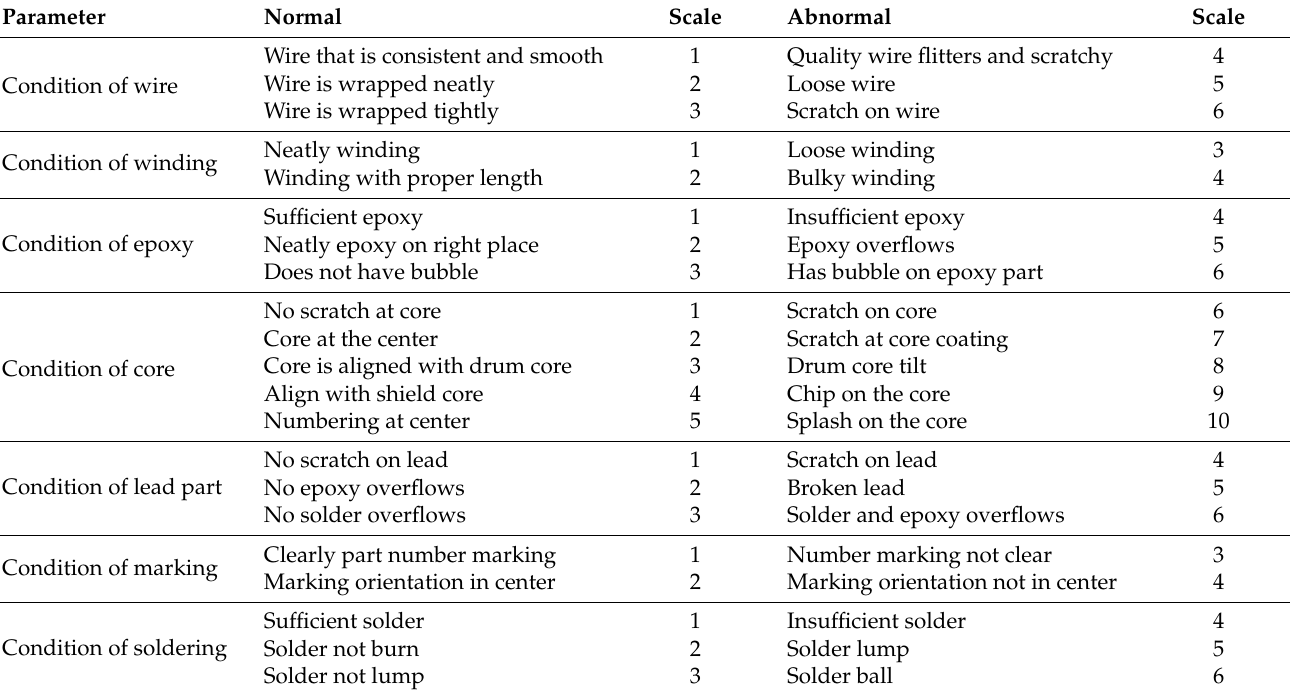
Table 2. Scales and conditions of normal and abnormal